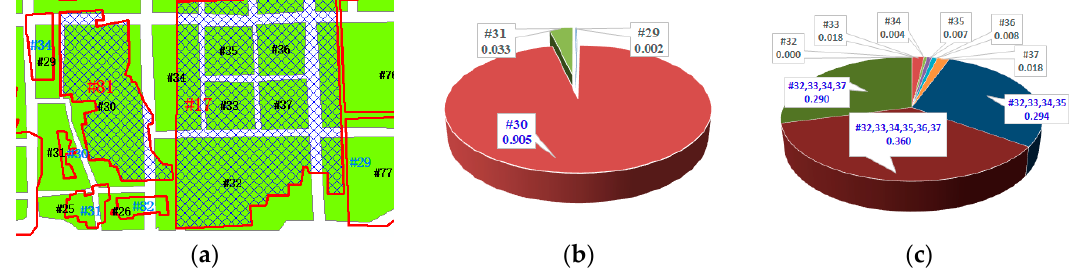
Figure 10. Comparing the probabilities of matching with an individual object and simultaneously matching with multiple objects: ( a ) object #81 and # 17 in R and their candidate ‐ matching objects in T ;